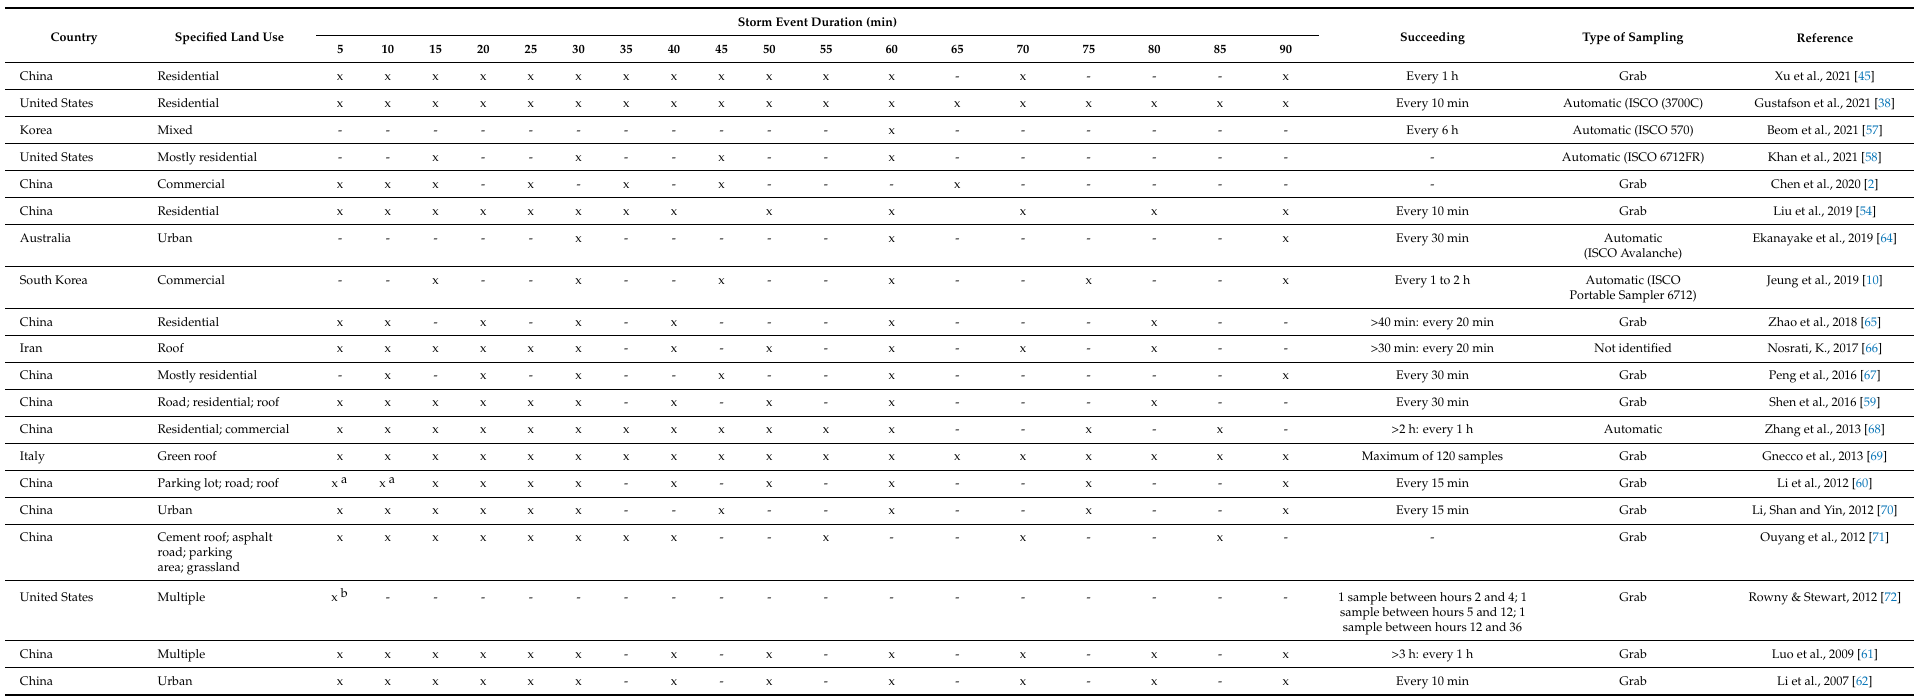
Table 3. Summary of stormwater runoff monitoring and sampling collection methods on various land use